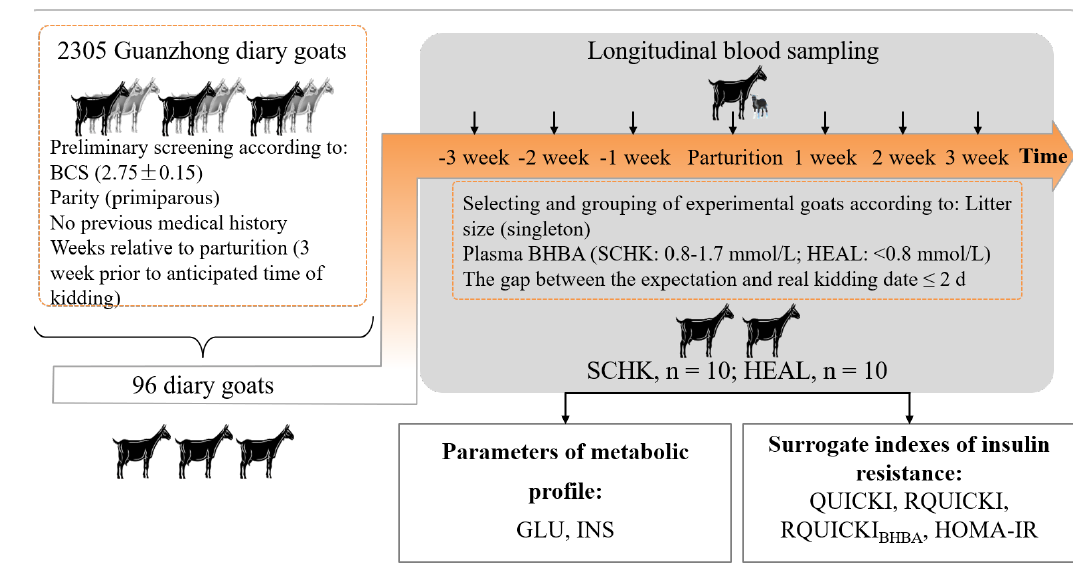
Figure 1. Study design. Two steps were used to screen and group animals. In the first step, 2035 Guanzhong dairy goats in the farm were subjected to estrous synchronization in September so that kidding occurred in February. Then, 96 Guanzhong dairy goats were enrolled and chosen from 2305 Guanzhong dairy goats according to BCS (2.75 ± 0.15), parity (primiparous), expected kidding date (within the first week of February), and no medical history. The blood samples were taken from the jugular vein of each goat at − 3, − 2, − 1, 0 (partum), +1, +2, and +3 weeks relative to delivery, using vacutainer tubes with sodium heparin. The second step was to select these experimental goats by the litter size of singleton and allocate them to one of two groups according to their plasma BHBA concentrations, as either SCHK ( n = 10; BHBA = 0.8 – 1.7 mmol/L) or HEAL ( n = 10; BHBA < 0.8 mmol/L). Finally, the plasma biomarkers of metabolites were measured, and sIR were calculated.